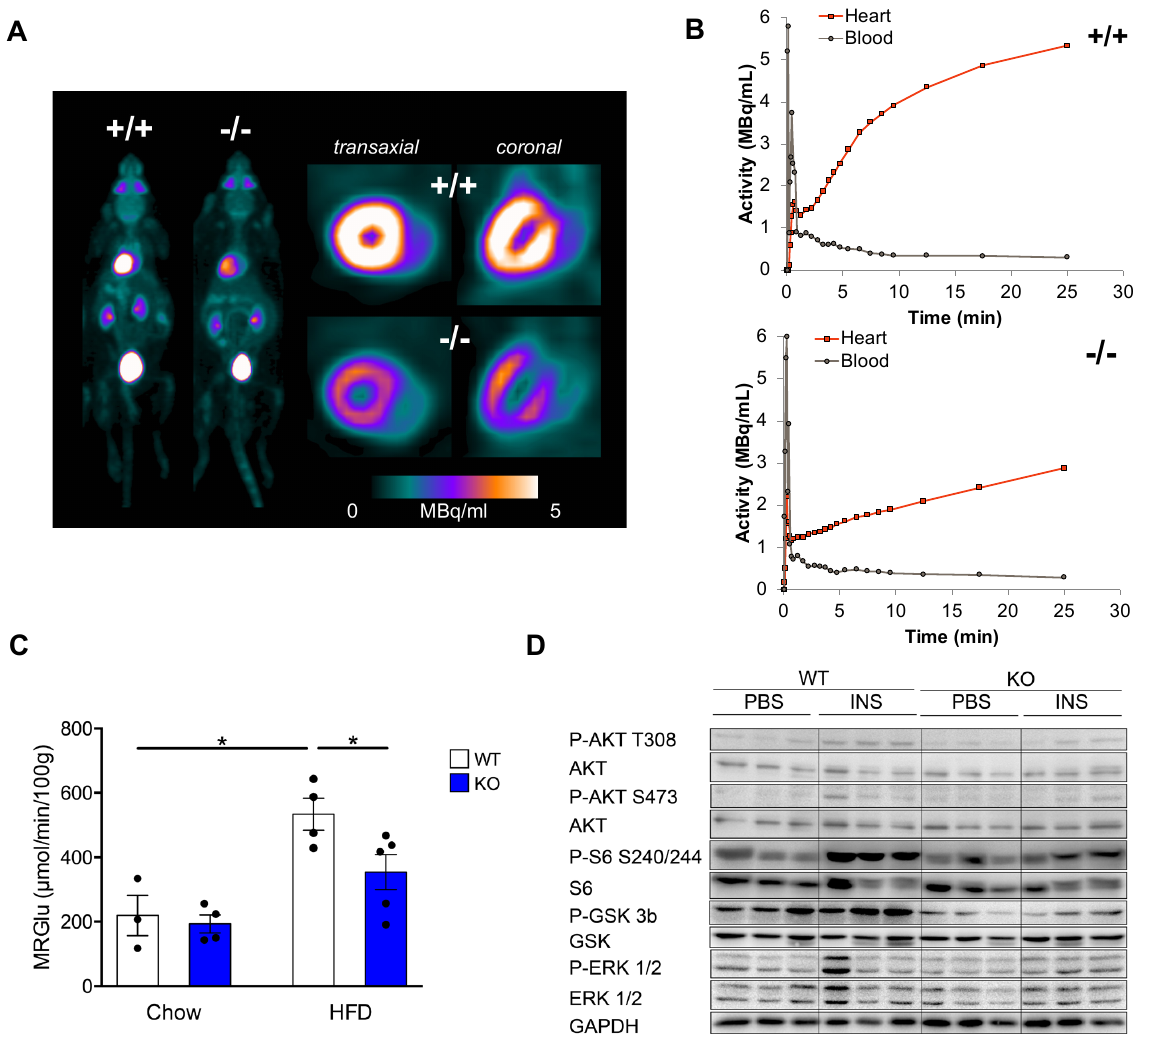
F Figure 3. Cont